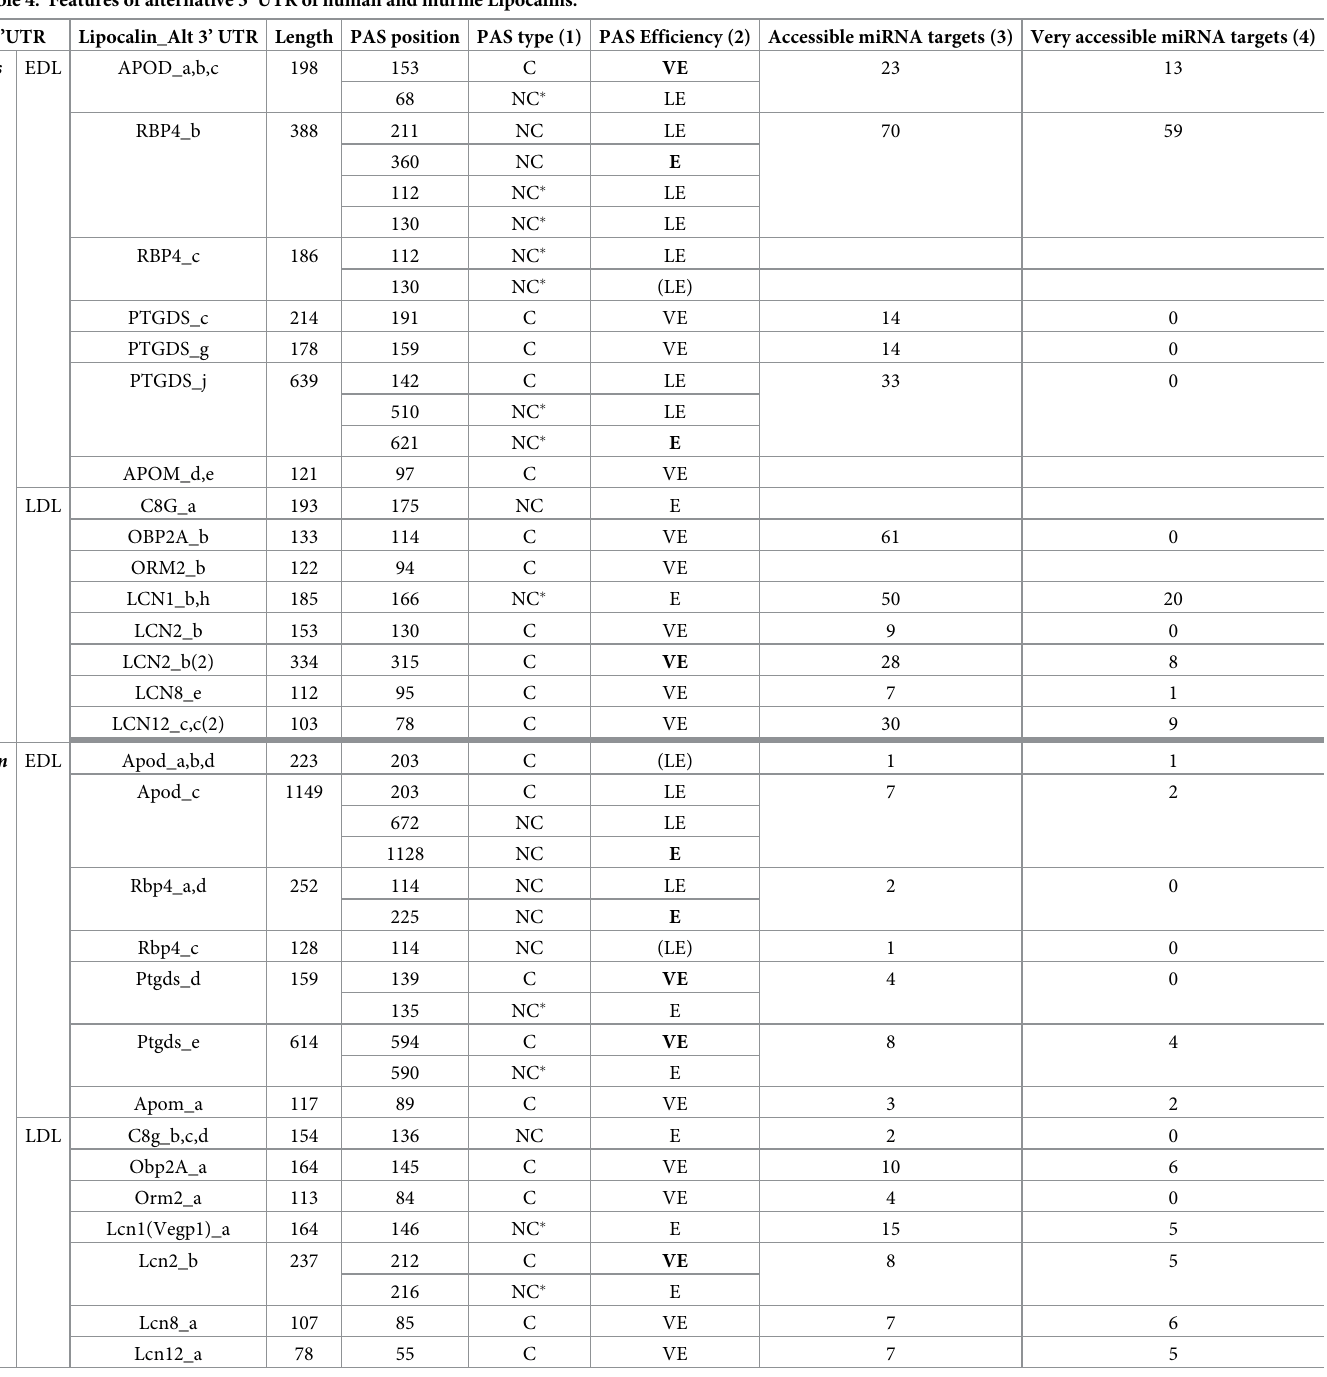
Table 4. Features of alternative 3’ UTR of human and murine Lipocalins.